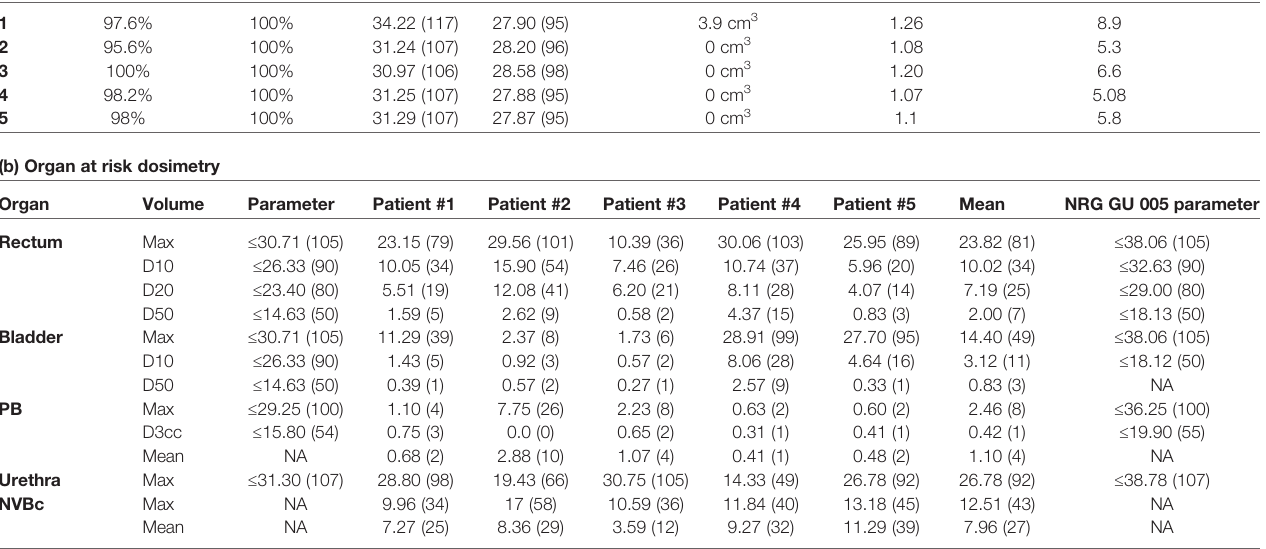
TABLE 4 | Pretreatment and 3-month posttreatment IPSS and SHIM scores.